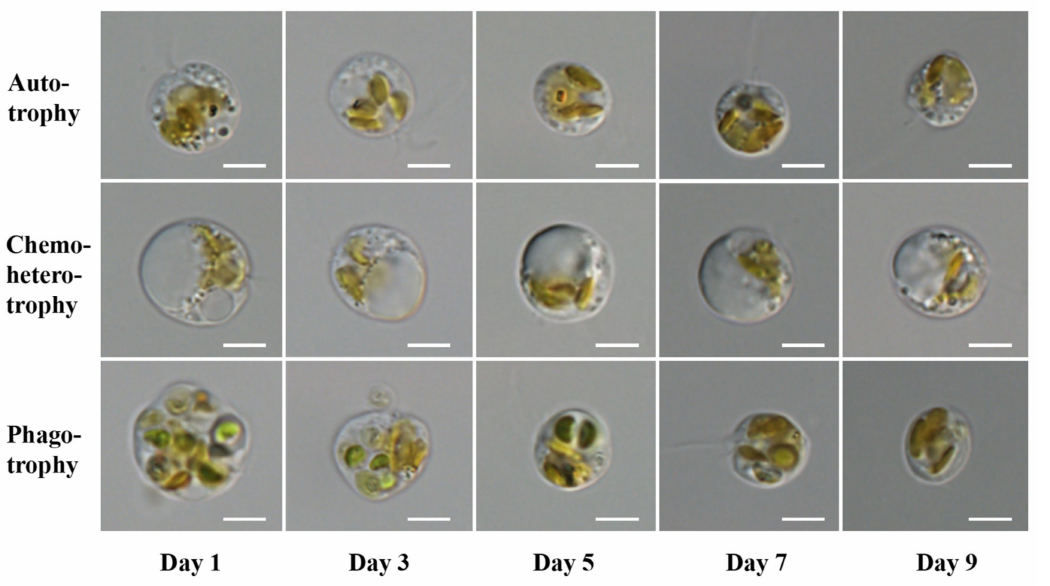
Figure 3. Cell morphologies of P. malhamensis with different nutritional modes at different times during cultivation. Scale bar = 5 µ m.